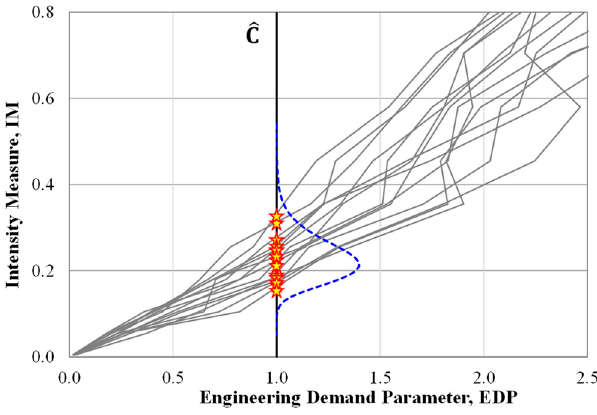
Figure 2. Set of IDAs curves and corresponding values of IM at the level of capacity C(cid:3553) .